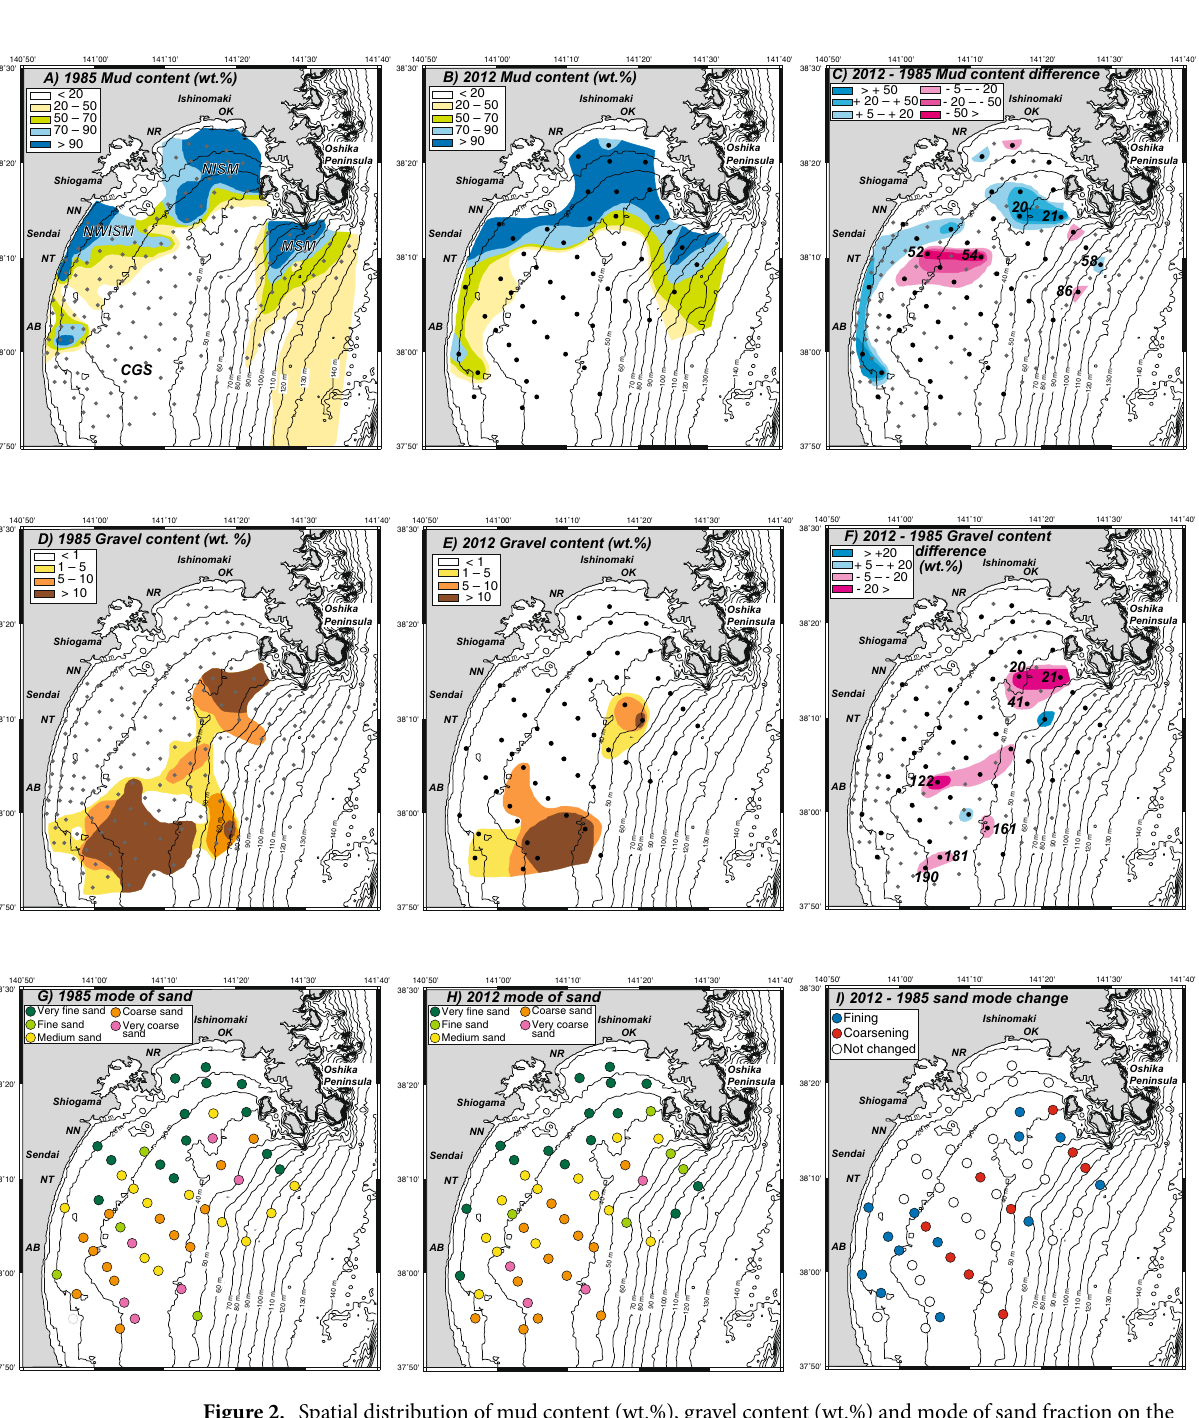
Figure 2. Spatial distribution of mud content (wt.%), gravel content (wt.%) and mode of sand fraction on the pre- (in 1985; A , D , G ) and post-tsunami (in 2012; B , E , H ) Sendai shelf, and these differences ( C , F , I ). NISM northern inner shelf mud, NWISM northwestern inner shelf mud, MSM mid-shelf mud, CGS central gravelly sediments. The boundary between the upper and lower sandy sediments was sharp, while erosional surface cut the burrow structures of the lower sandy sediments (Fig. 3B). The upper sandy sediments were usually better sorted than the lower ones (Fig. 3B). The thickness of the upper sandy sediments was only 1– ~ 8 cm (Fig. 3C). Well-sorted medium sand was found at Site 122, although in the 1985 survey, poorly sorted gravelly sand was identified at this site (Supplementary Fig. S1A). Well-sorted coarse–very coarse sand with homogeneous structure covered the poorly sorted gravelly sand at Site 56 (Fig. 3B). A similar gravelly sand was also found at the seafloor in 1985 (Fig. 3B). At Site 190, homogeneous coarse–medium sand covered the gravelly coarse sand (Fig. 3B), where the gravel content of the surface sediments was reduced. At Site 80, bioturbated very fine sand changed to parallel laminated very fine sand with some small burrows near the core top (Supplementary Fig. S1B), implying